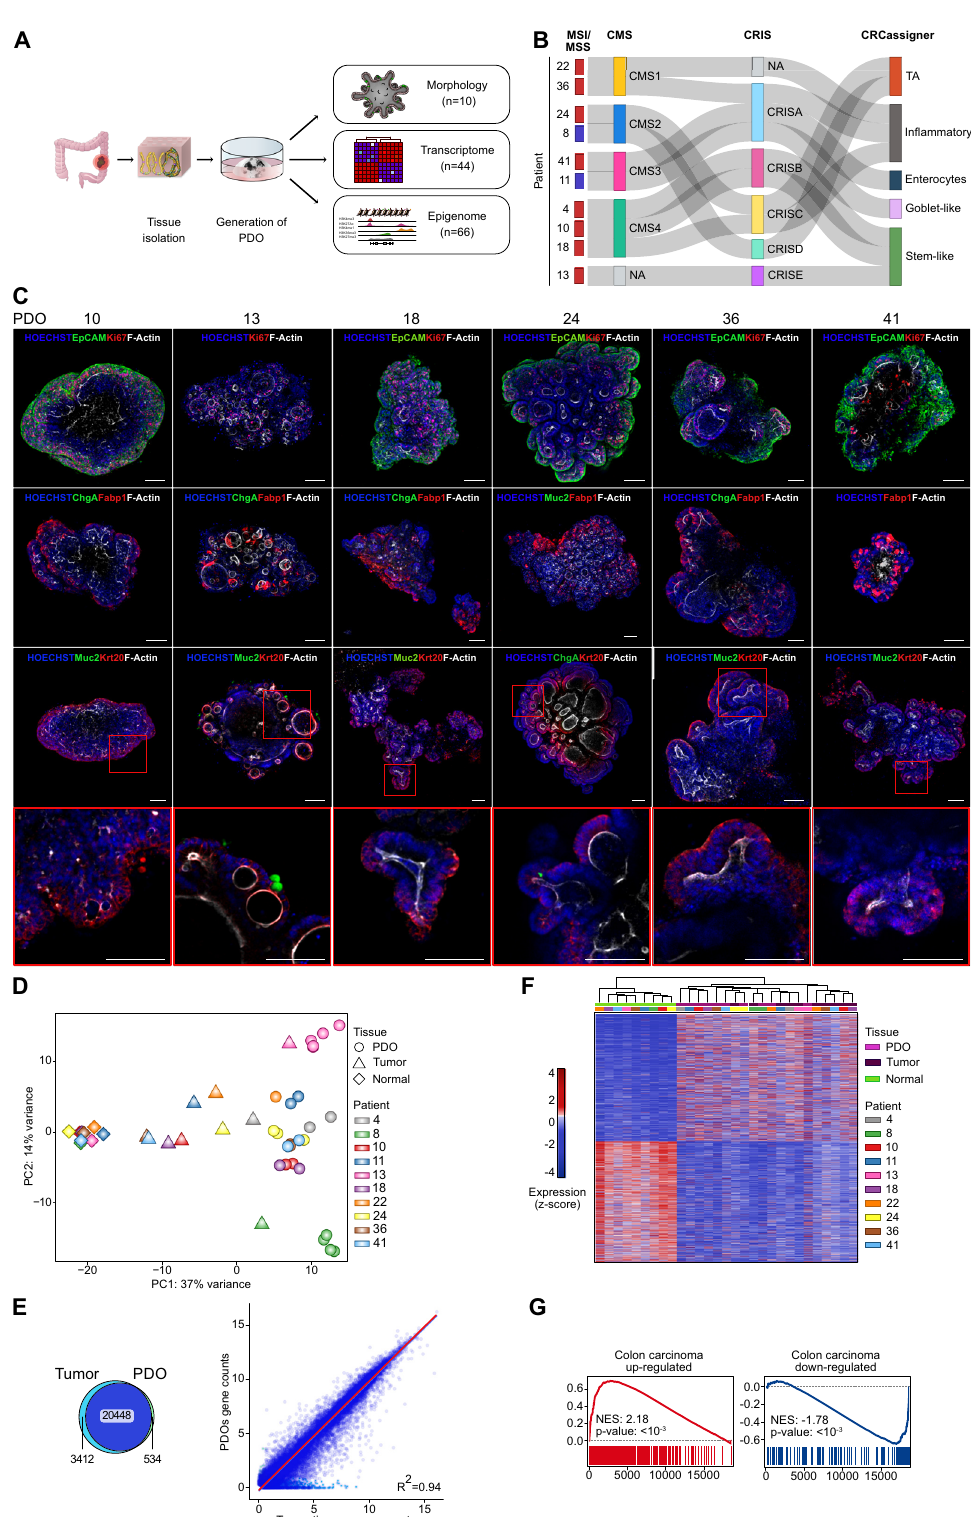
subtypes is suitable for deciphering the epigenetic blueprints of the CRC-cell intrinsic phenotype. Towards this aim, we fi rst performed a multi-factorial integrative analysis of genome-wide chromatin immunoprecipitation sequencing (ChIP-seq) for a core set of fi ve histone modi fi cations (H3K4me3, H3K27ac, H3K4me1, H3K36me3, and H3K27me3) on all PDOs (Fig. 2a and Supplementary Data 1). Unsupervised hierarchical clustering and